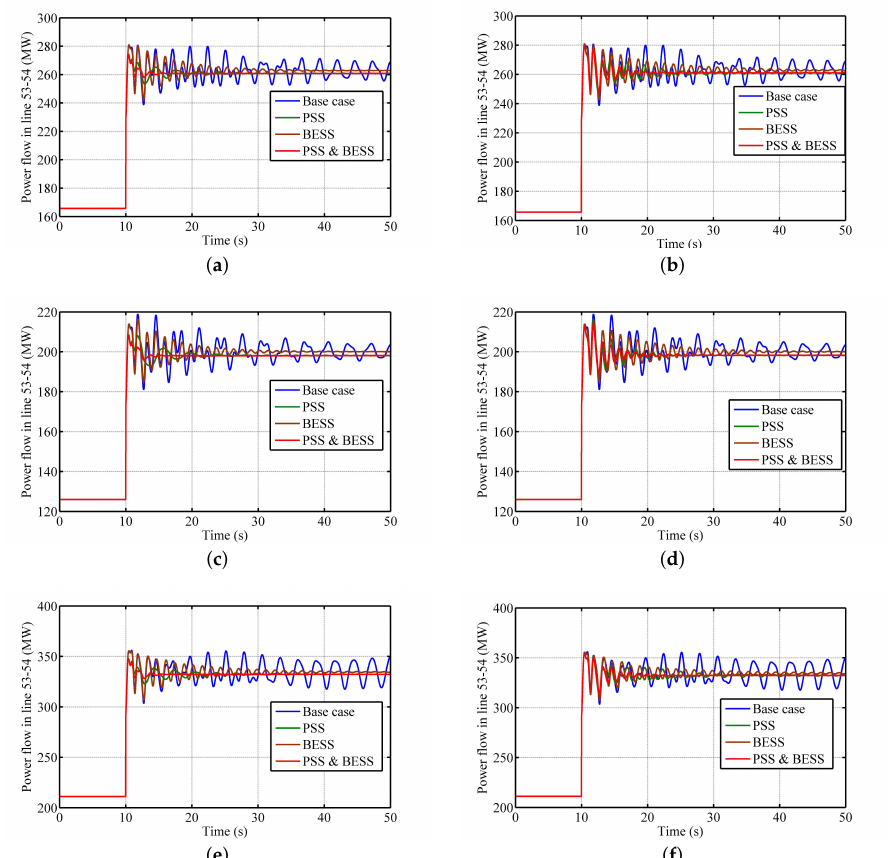
Figure 14. Time-domain simulations under different scenarios. ( a ) Responses using the proposed method under Scenario 1. ( b ) Responses using OBTM under Scenario 1. ( c ) Responses using the proposed method under Scenario 2. ( d ) Responses using OBTM under Scenario 2. ( e ) Responses using the proposed method under Scenario 3. ( f ) Responses using OBTM under Scenario 3.